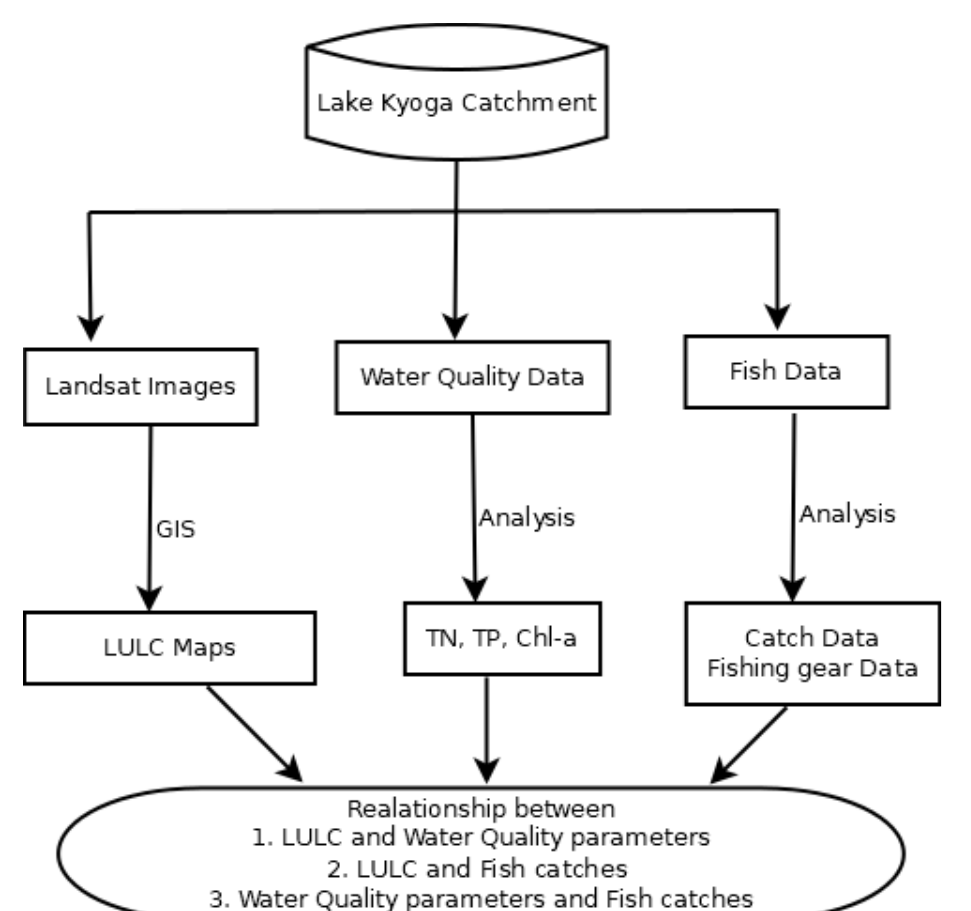
Figure 4. A flow chart showing the relationship of LULC with water quality and fish catches within the immediate catchment of Lake Kyoga.